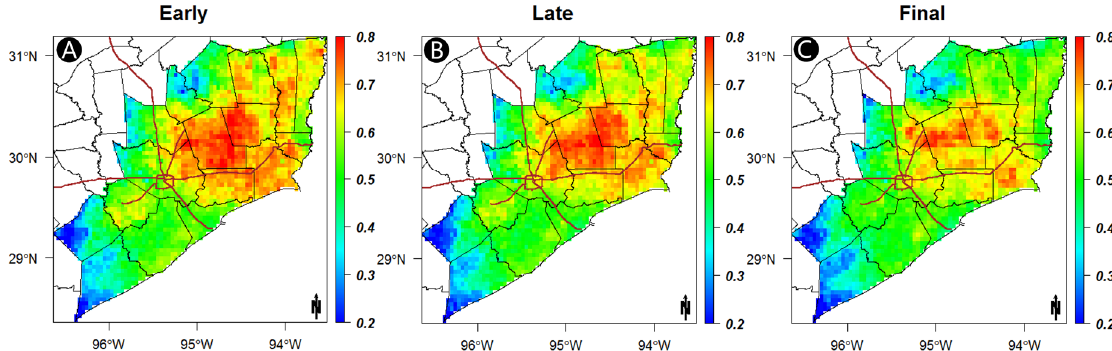
Figure 12. Spatial distribution of CSI for the IMERG ( A ) Early-, ( B ) Late-, and ( C ) Final-run products during Tropical Storm Imelda.